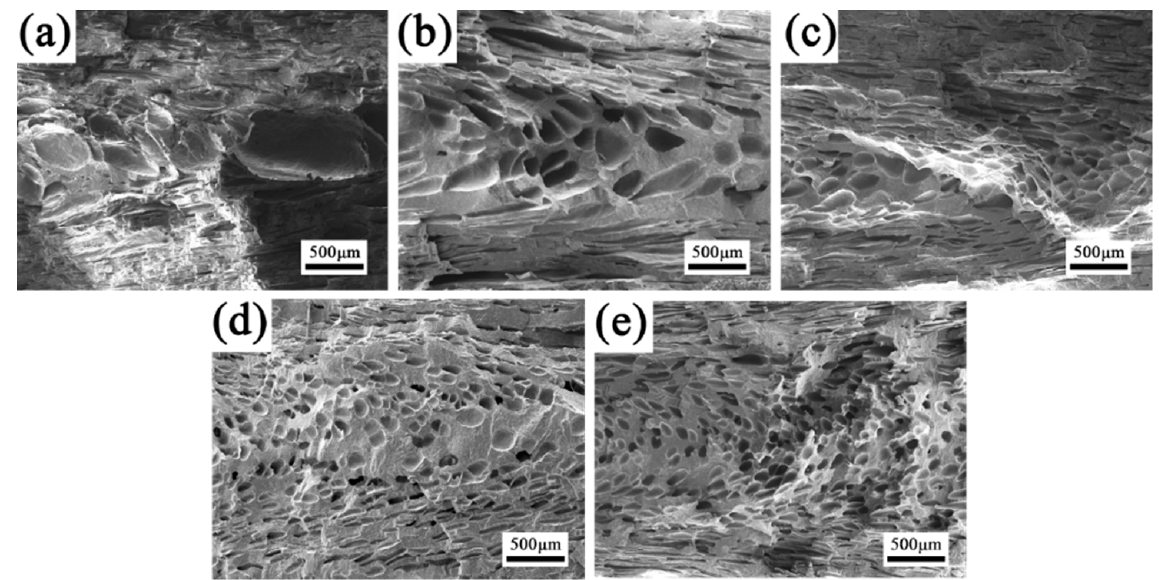
Figure 11. SEM images of the cellular structure along FD of foamed samples: ( a ) neat PP, ( b )